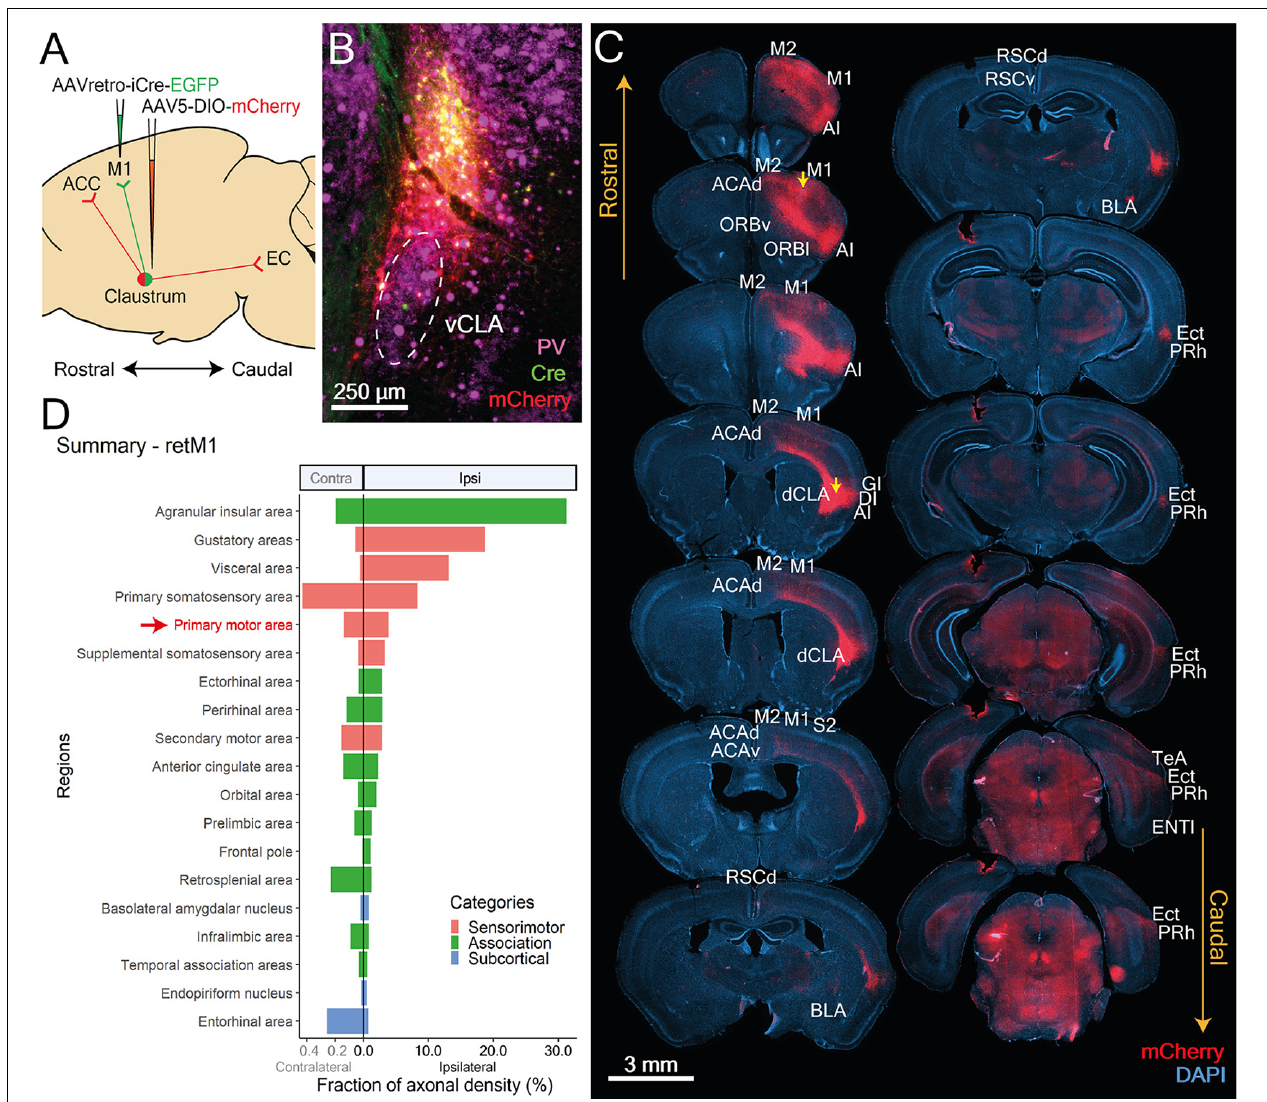
FIGURE 5 | CLA neurons projecting to M1 localize in the dorsal CLA and co-project to sensorimotor-related cortical regions. (A) Illustration of double virus injection strategy used to label CLA neurons projecting to the M1 and their axons. (B) CLA-specific expression of Cre and mCherry based on experiment shown in (A) . vCLA core boundaries (white dotted ellipse) are demarcated based on parvalbumin (PV) antibody staining. (C) Mapping of axon collateral from M1-projecting CLA neurons. Raw images of mCherry expression against DAPI stained coronal sections. Yellow arrows denote viral injection sites. Regions receiving axons are labeled. M1, M2, Primary and secondary motor cortex; AI, Agranular insula; ACCd, Anterior cingulate cortex dorsal; ORBv, ORBl, Orbital cortex ventral, lateral; GI, DI, Granular, Dysgranular Insula; dCLA, dorsal claustrum; RSCd, vRSCv, Retrosplenial cortex dorsal, ventral; S2, Secondary somatosensory cortex; BLA, Basolateral amygdala; Ect, Ectorhinal cortex; Prh, Perirhinal cortex; TeA, Temporal association cortex; LEC, Lateral entorhinal cortex. (D) Mean fraction of axonal density for all innervated regions, sorted by labeling strength. Red arrow and text identifies retrograde Cre origin: M1. Agranular insula, gustatory, visceral, and primary somatosensory cortices had heavier innervation compared to M1. Colors represent region categories: Association—green; Sensorimotor—pink; and Subcortical—Blue. Note different ranges for contralateral and ipsilateral